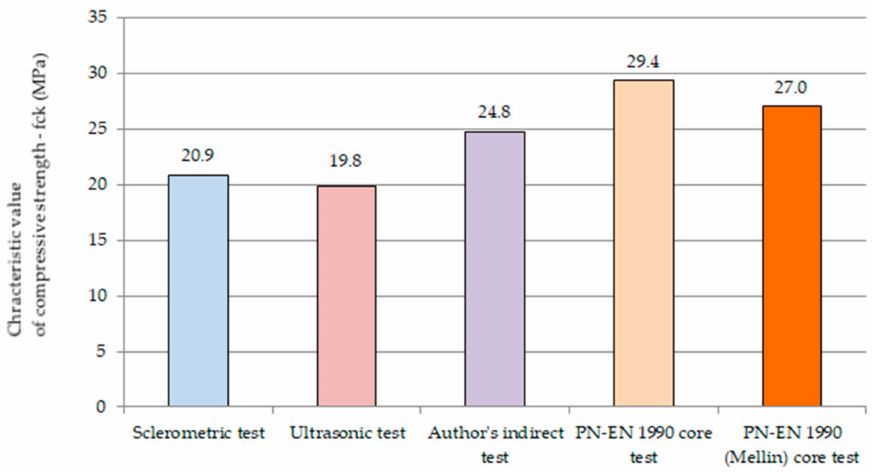
Figure 15. Characteristic values of compressive strength obtained using different